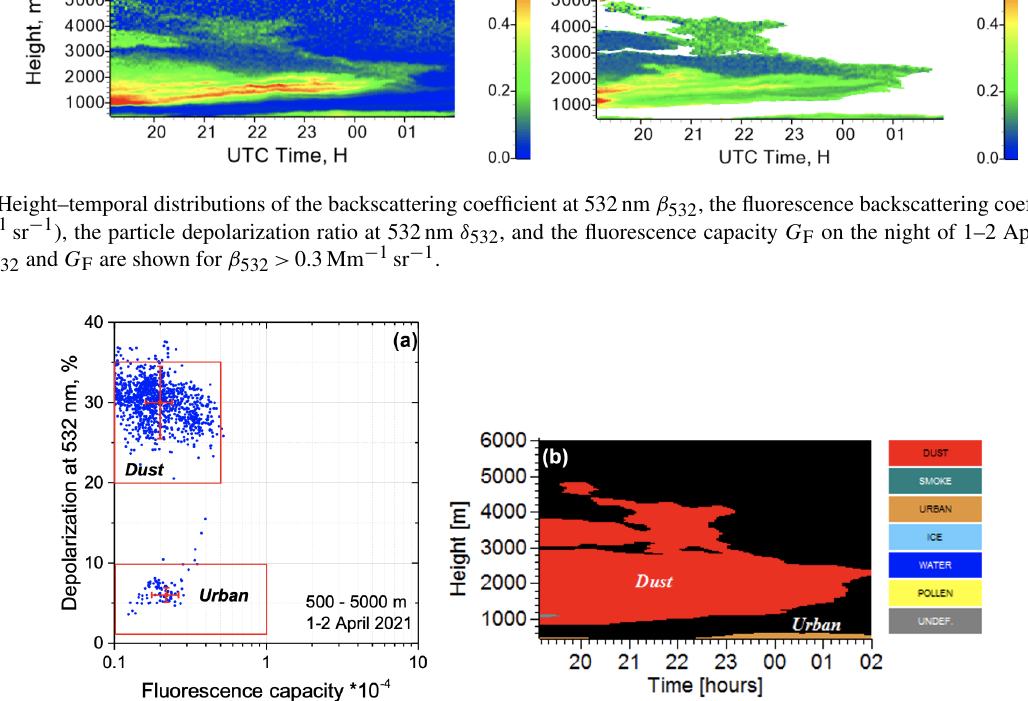
Figure 18. (a) The δ 532 - G F diagram for observations in the 500–5000m height range and (b) spatiotemporal distribution of aerosol types on the night of 1–2 April 2021. Measurements with β 532 < 0.3Mm − 1 sr − 1 are marked in